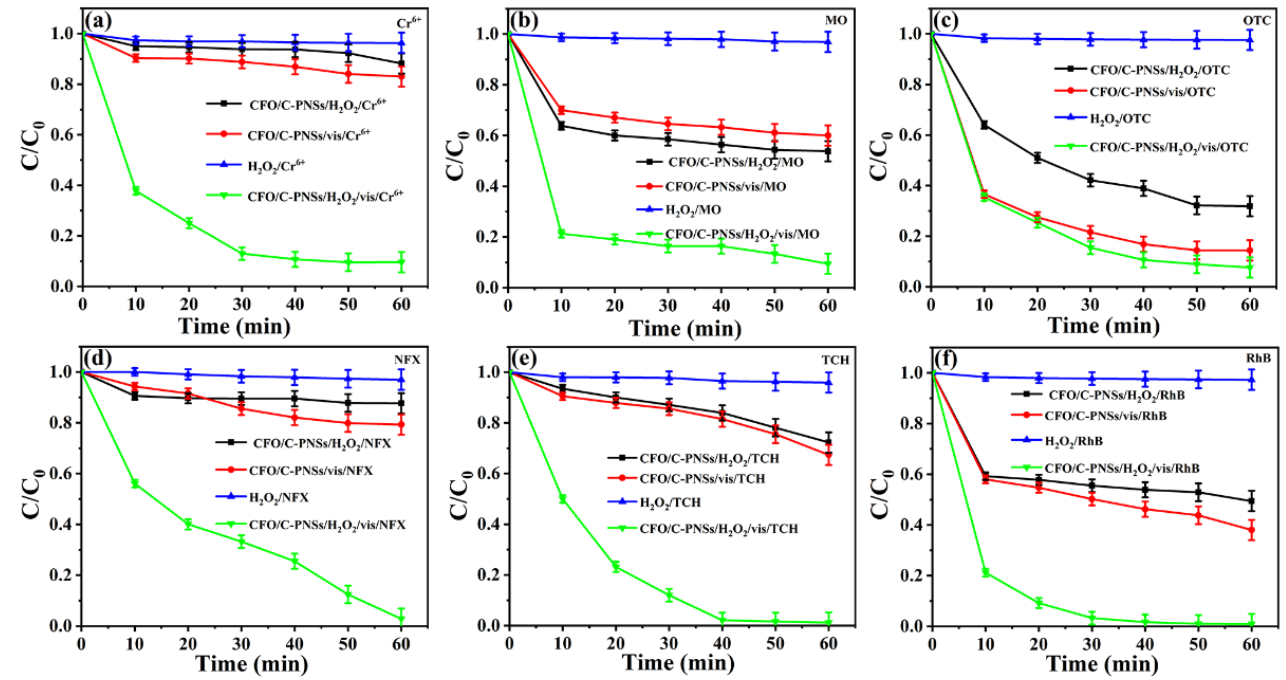
Figure 7. The photocatalytic degradation of ( a ) Cr(VI), ( b ) MO, ( c ) OTC, ( d ) NFX, ( e ) TCH and ( f ) RhB by CFO/C-PNSs with different conditions under visible-light irradiation.